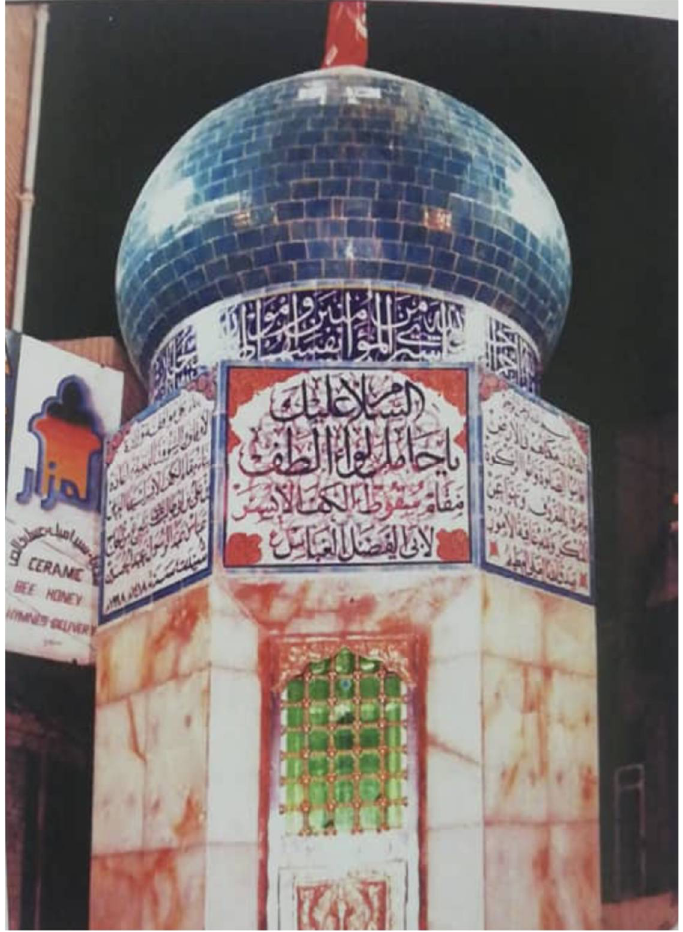
Figure 10. A Contrast between good and evil: The Zaynab Hillock Dome. Source: Ahmad Alavi